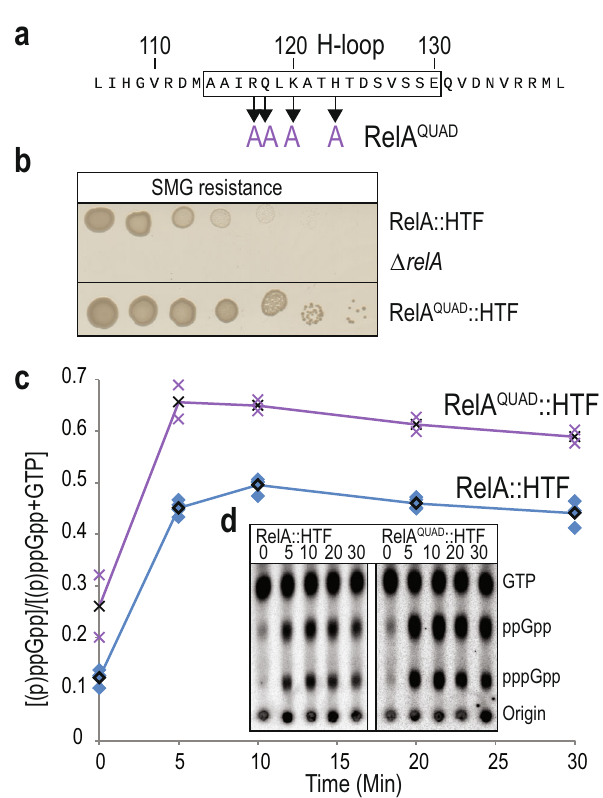
Fig. 5 Alanine substitutions in the H-loop leads to increased (p)ppGpp synthesis. a Primary sequence of the H-loop region (indicated within a box) of RelA. Arrows indicate positions which have been substituted to alanine in RelA QUAD (R117A, Q118A, K120A and H123A). b Functional assay of RelA QUAD . Cell cultures of MG1655 relA::HTF , MG1655 Δ relA and MG1655 relA QUAD ::HTF , were washed in PBS, serial diluted and spotted onto MOPS MM SMG plates (SMG resistance). The plates were incubated ON at 30 °C (See Supplementary Fig. 1f for loading controls). c (p)ppGpp measurements of strains in b ). Cells were grown exponentially in MOPS minimal medium containing 32 P-labeled phosphate. Isoleucine starvation was induced by addition of L-valine, to a fi nal concentration of 500 μ g/mL. Samples were collected before (time zero) and after starvation, precipitated and separated by thin layer chromatography. The RelA QUAD ::HTF curve with black crosses is based on the average of n = 2 biological independent samples see Supplementary Fig. 1m and 1n. d Representative TLC from a , positions of GTP, ppGpp and pppGpp are